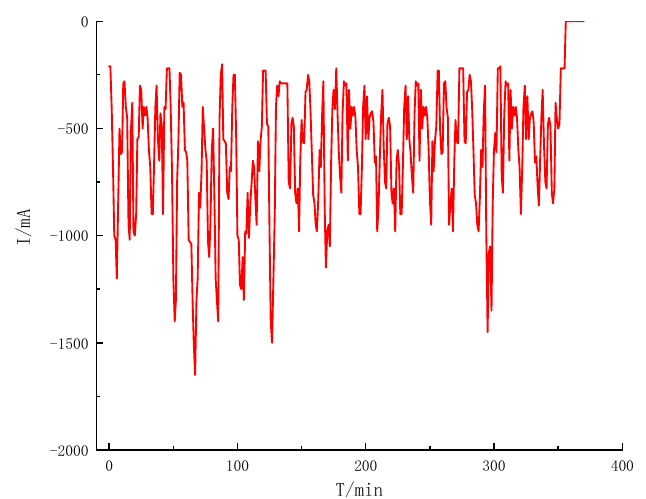
Figure 3. UDDS working current diagram.